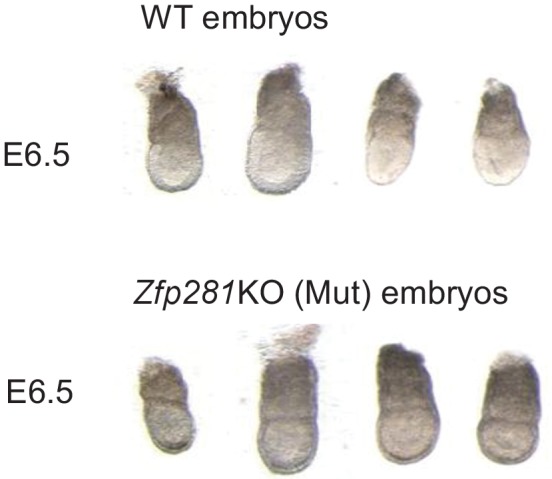
Images of E6.5 WT and Zpf281KO embryos used for RNA-seq analysis.For each genotype, n = 4 embryos.